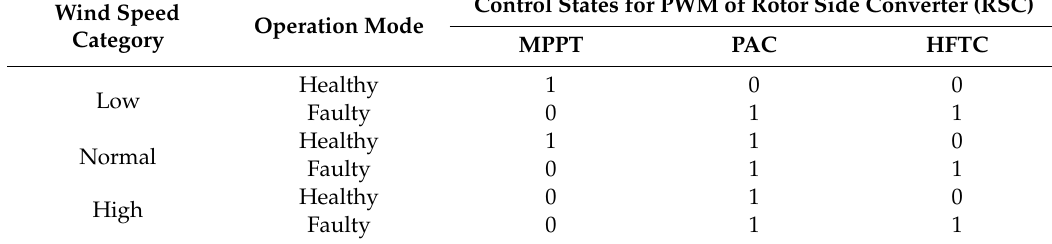
Table 3. Hierarchical operation table of the implemented fault tolerant control (FTC) scheme. PAC, pitch angle control; MPPT, maximum power point